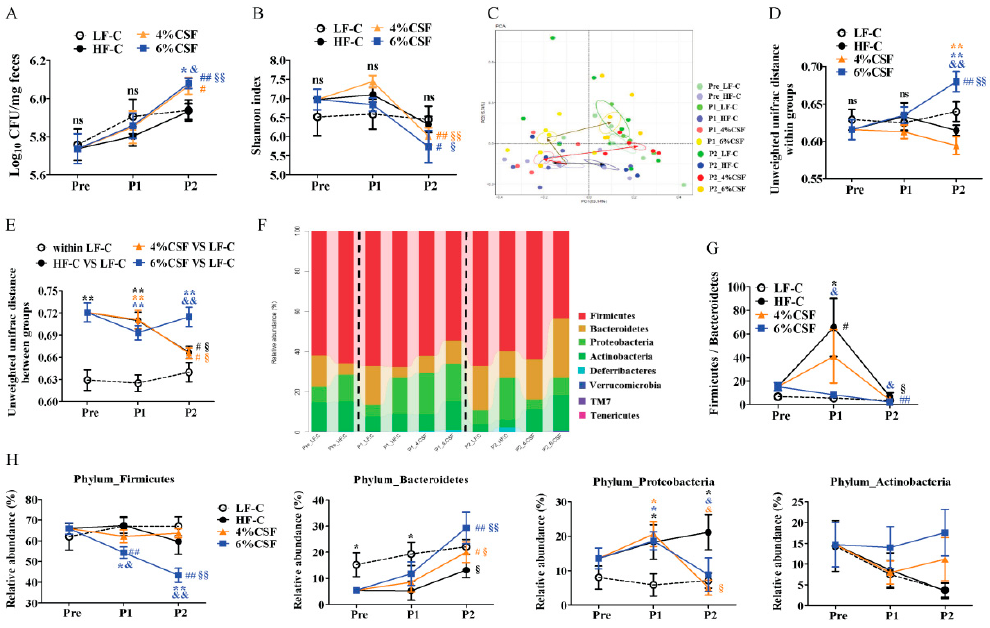
Figure 4. CSF alters the gut microbiota composition. ( A ) Total bacteria load (n = 7). ( B ) The alpha diversity of feces microbiota as a function of time (n = 5–7). ( C ) The principal component analysis (PCA) of feces microbiota (n = 5–7). The circle shows a 10% confidence interval (CI). ( D , E ) The unweighted unifrac distance within ( D ) and between ( E ) groups calculated at the operational taxonomic unit (OTU) level across individual microbiota. ( F ) The changes in bacterial abundance at the phylum level. ( G ) The Firmicutes/Bacteroidetes ratio in different groups. ( H ) The changes in relative abundance of Firmicutes, Bacteroidetes, Proteobacteria and Actinobacteria. Data are expressed as mean ± SEM. Statistical significance was assessed by Tukey’s test for multiple comparisons. *, ** p < 0.05 and 0.01 respectively compared with the LF-C group. & and && indicate p < 0.05 and 0.01, respectively, compared with the HF-C group. # and ## indicate p < 0.05 and 0.01, respectively, compared with the pre-treatment group. § and §§ inicate p < 0.05 and 0.01, respectively, compared with the treatment period 1. ns —not significant, p > 0.05. The black, orange, and blue symbols represent the statistical analysis of HF-C, 4% CSF, or 6% CSF groups, respectively, with other groups or the same group at different time points.